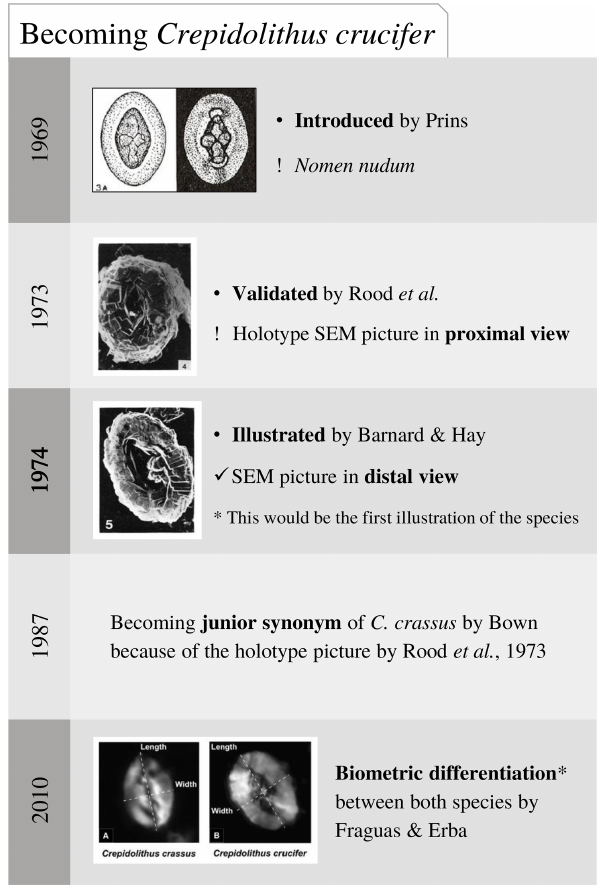
Figure 3. Some studied species have a complicated taxonomic his- tory, like Crepidolithus crucifer . Images adapted after Prins (1969), Rood et al. (1973), Barnard and Hay (1974), and Fraguas and Erba